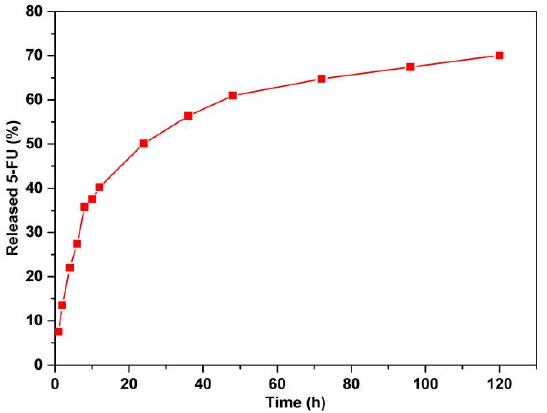
Figure 8. Release of 5-FU from the drug-loaded complex 1a (% 5-FU vs. time).